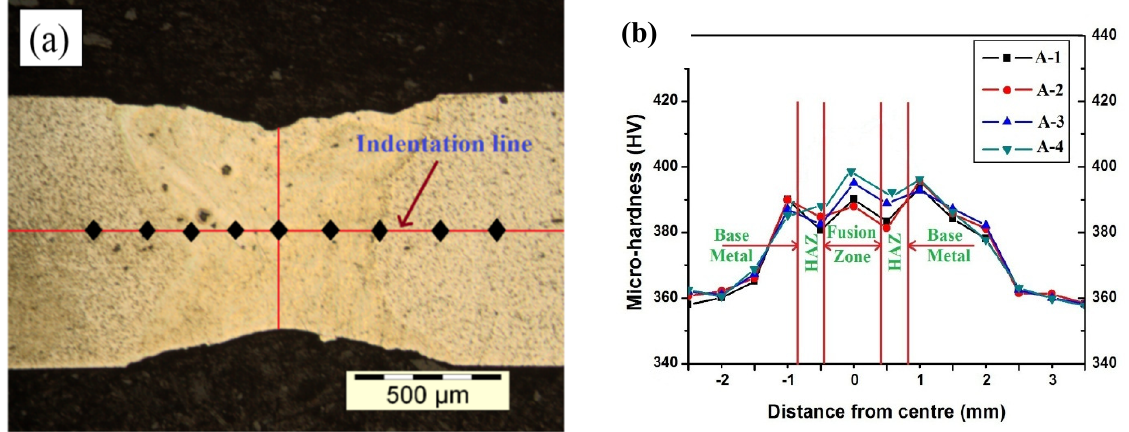
Figure 11. ( a ) Indentation line of the welded joint. ( b ) Micro-hardness profiles across weld center line.